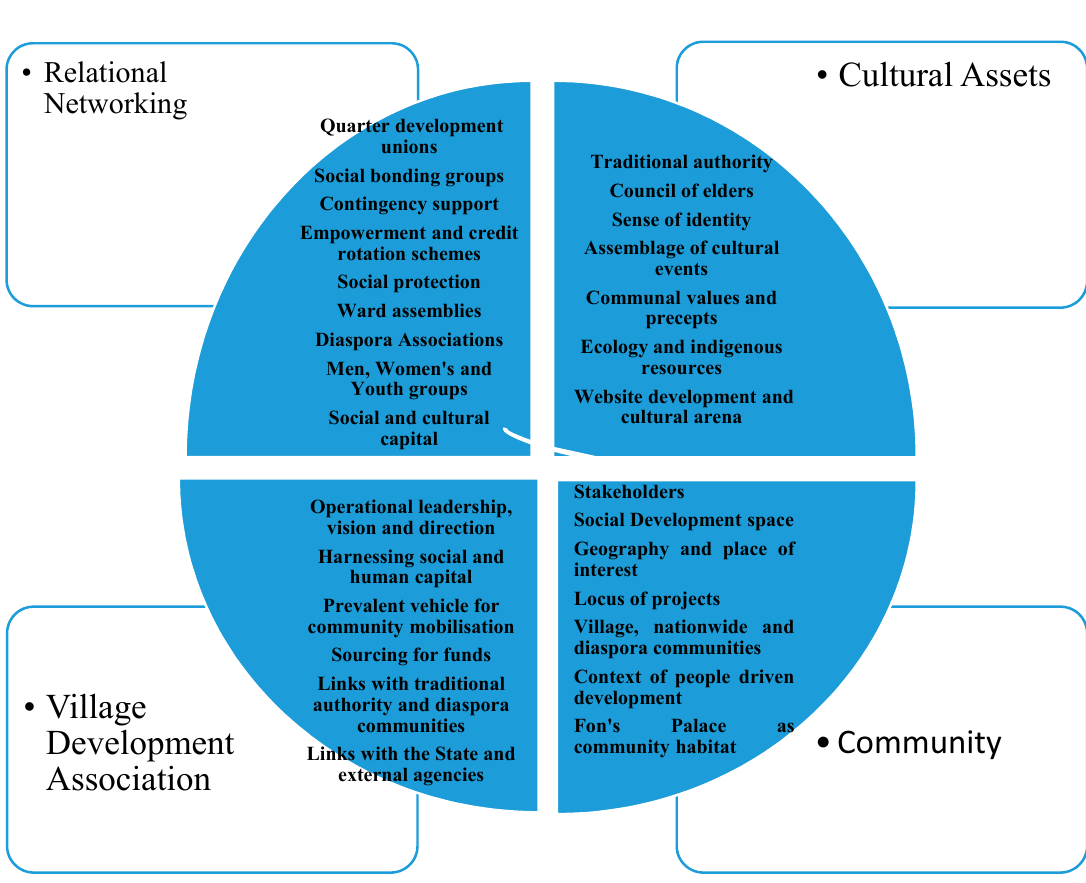
Figure 1. Intersection Framework and Elements of Relational Networking and Cultural Assets. With an estimated population of over 21 million, Cameroon is an ethnically and geographically